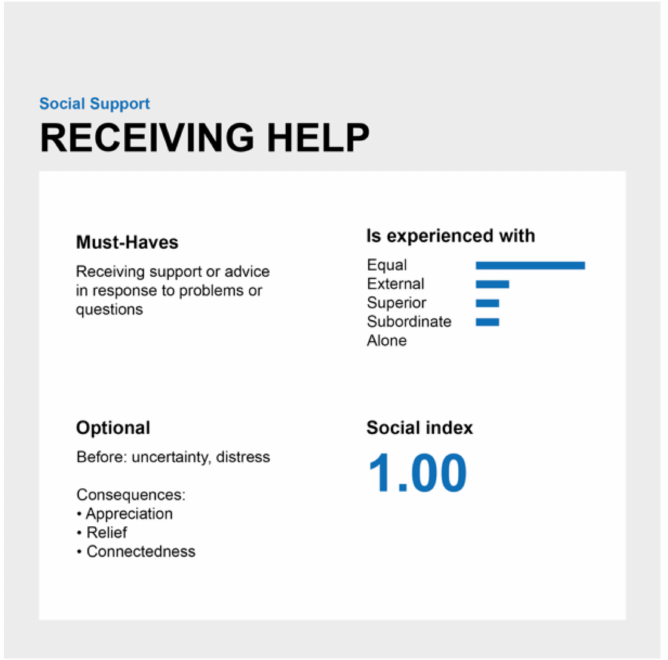
Figure 1. Experience card for experience category Receiving Help in the Social Support cluster based on Zeiner and colleagues